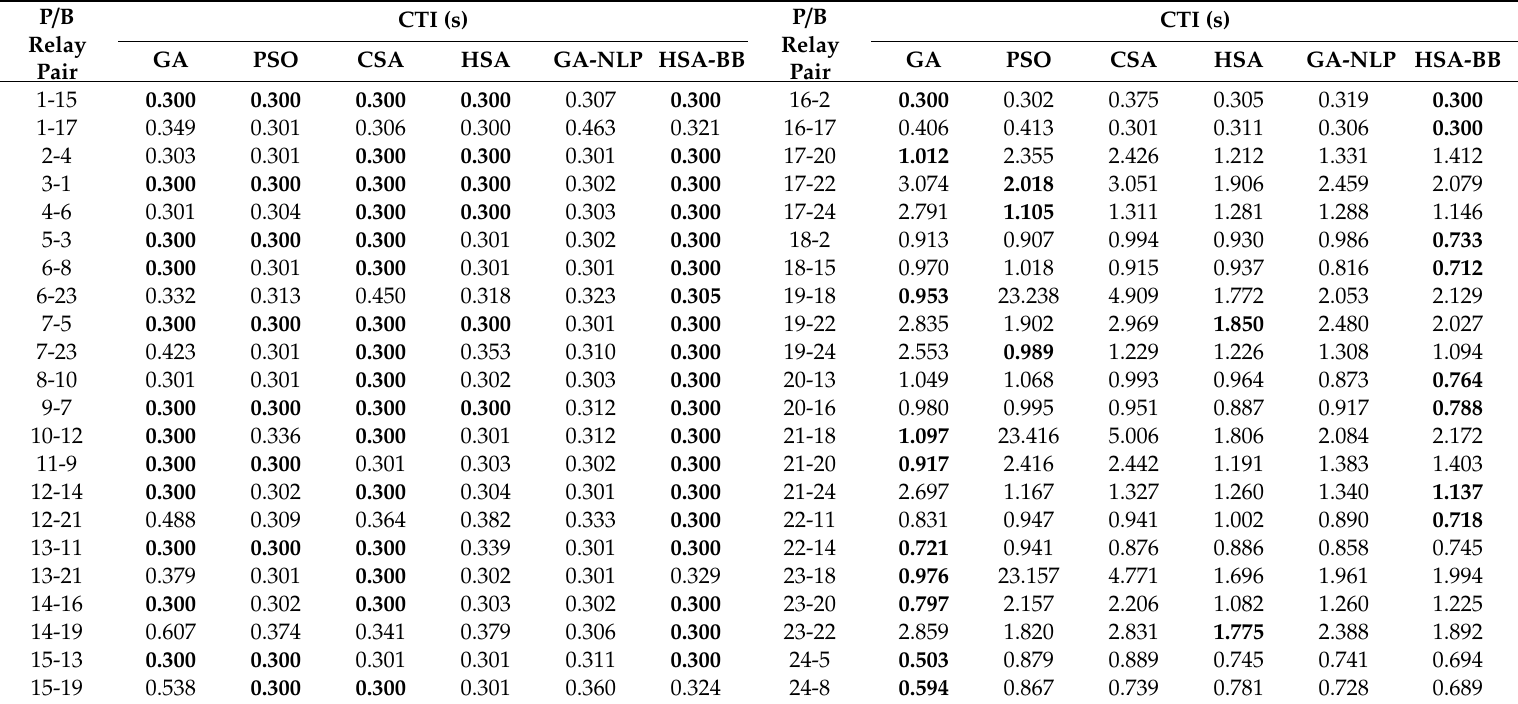
The bold digits represent the minimum CTI